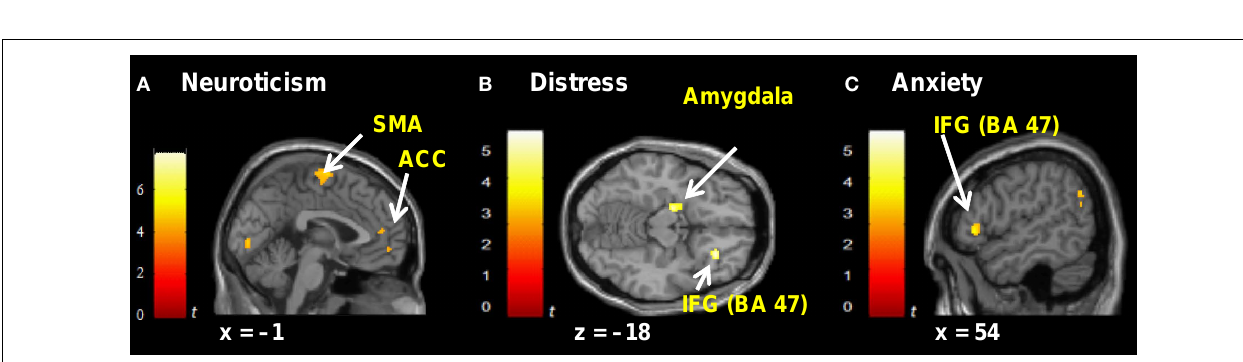
FIGURE 5 | Correlated dispositional measures and brain activity during observation of avatar in pain. Prediction of hemodynamic changes in activation during observation of the avatar in pain versus no pain by scores of Neuroticism (A) , Distress (B) and Anxiety (C) , superimposed on the coronal and sagittal sections of the single subject structural MNI template.